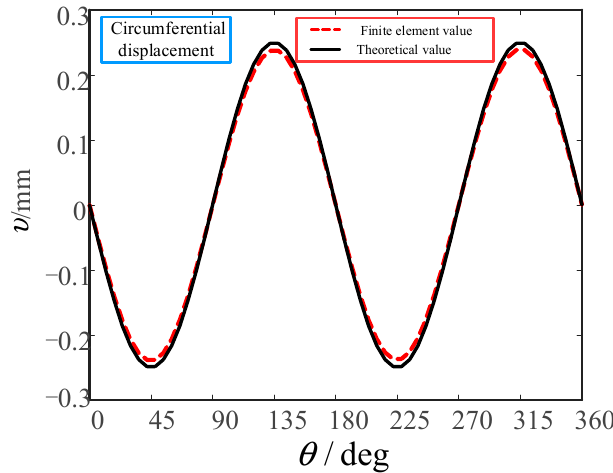
Figure 14. Comparison of the circumferential displacement of the flexible wheel neutral layer.